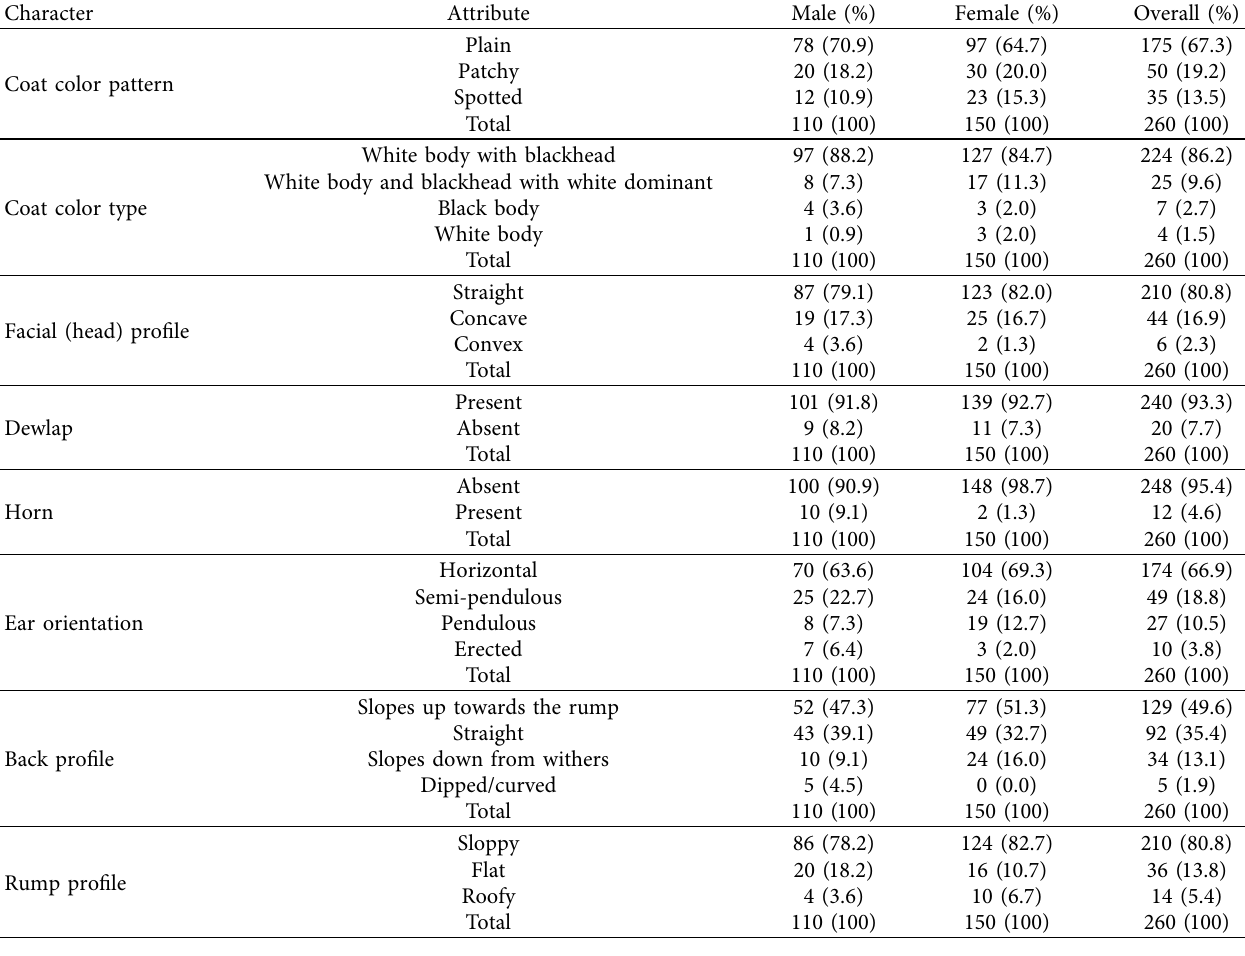
Table 1: Qualitative physical body characteristics of Blackhead Somali sheep.